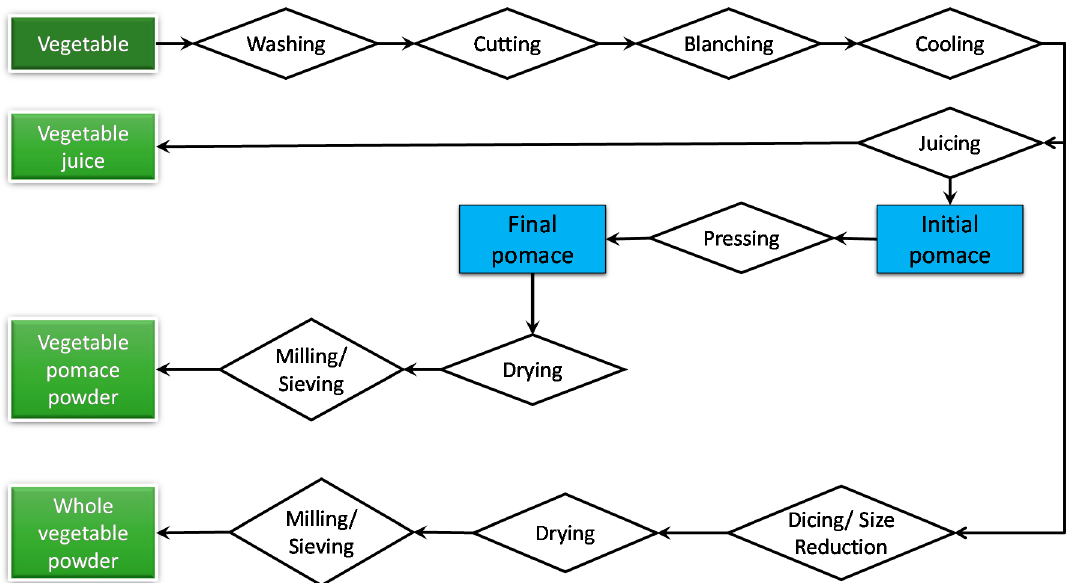
Figure 1. Generalised process for the preparation of vegetable powders. Trial 1: The drying method used was freeze-drying and whole-vegetable powder and pomace powder were produced. Trial 2: Fresh cut vegetables (sliced carrots and broccoli florets) were purchased from a commercial supplier and directly freeze-dried. Trial 3: Whole-vegetable powders were produced using drum drying.